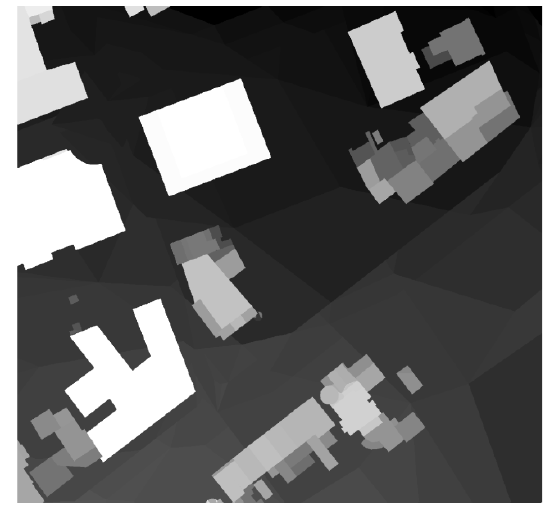
Figure 8. The study area of